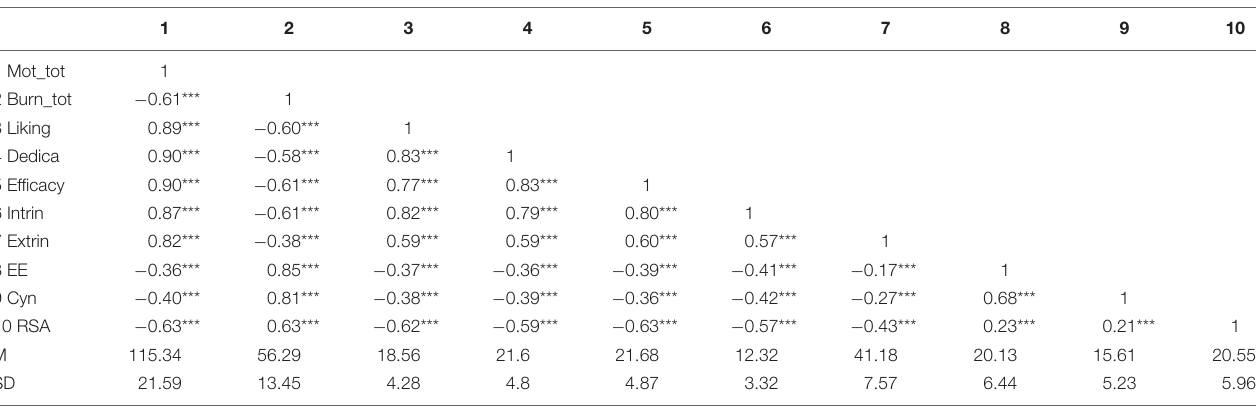
TABLE 1 | Correlations, means and standard deviations of motivation, burnout and subscales of